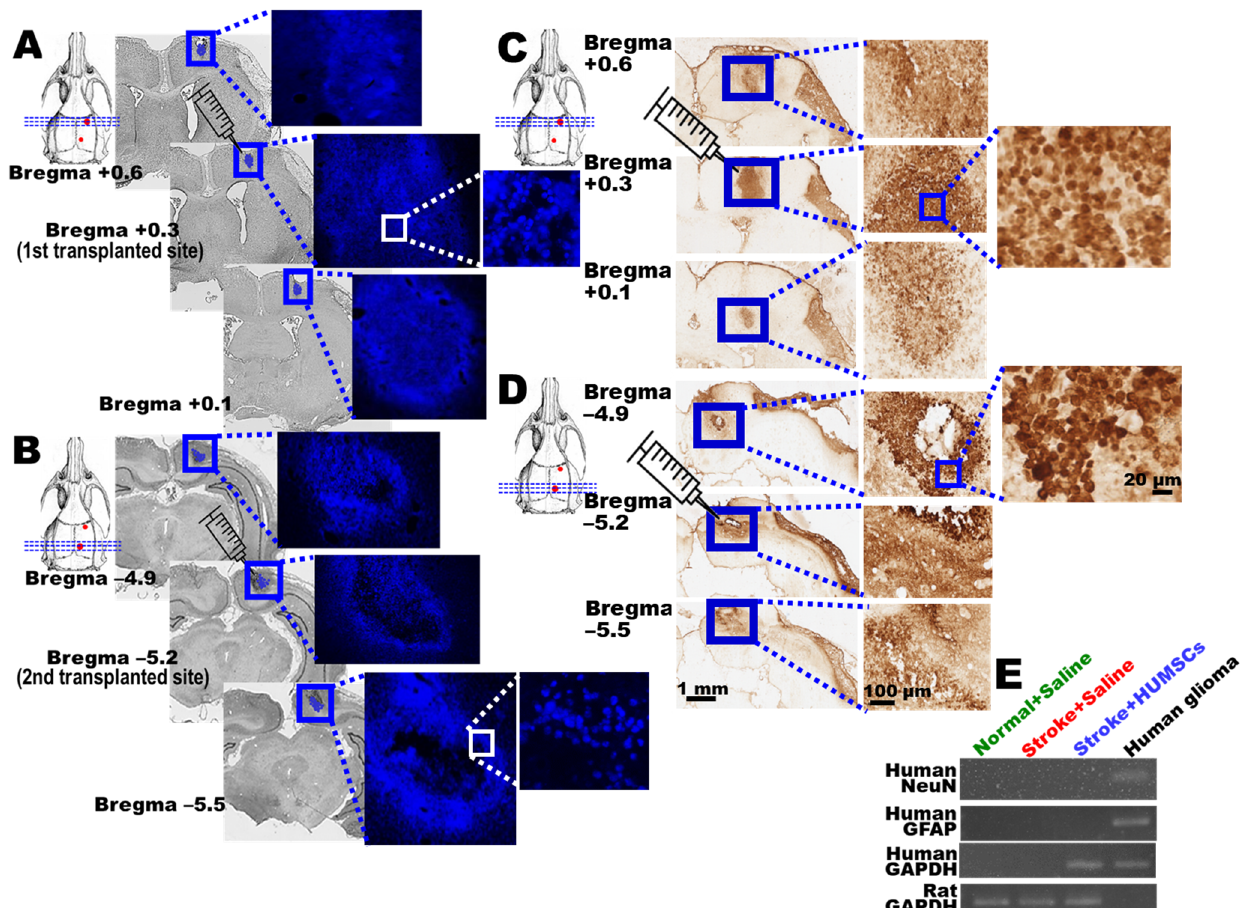
Figure 6. Grafted HUMSCs survived in the infarcted cortex and did not differentiate into neuronal cells or astrocytes . The nucleus of HUMSCs was labeled with bisBenzimide (blue), and the cells were transplanted into the rat’s right cerebral cortex on day 14 post stroke. On day 56, phase-contrast microscopy images of the HUMSCs group are displayed with the section at the first HUMSCs transplantation position of bregma +0.3 mm and its anterior (+0.6 mm) and posterior coronal sections (+0.1 mm). The blue clusters of cells were observed at high magnification ( A ). The second HUMSCs transplantation position at bregma − 5.2 mm and its anterior (bregma − 4.9 mm) and posterior (bregma − 5.5 mm) coronal brain sections are shown. At high magnification, clusters of cells labeled with bisBenzimide were found ( B ). Immunostaining for human-specific nucleus antigen demonstrates the aggregation of HUMSCs around the first ( C ) and secondary ( D ) transplantation sites at 56 days post stroke. The boxed areas in the left column are magnified in the right column. On day 56 post stroke, the cerebral cortex was subjected to RT-PCR tests to examine whether human NeuN or GFAP could be detected in all the groups. The results showed that the transplanted HUMSCs did not differentiate into neuronal cells or astrocytes ( E ).